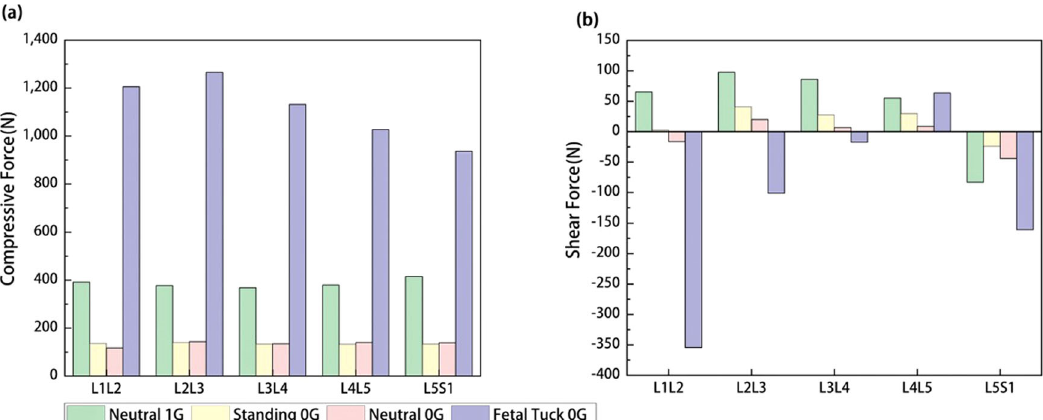
Fig. 2 Comparison of mechanical forces on lumbar discs among various postures in 1G gravity and microgravity. a Compressive force and b shear force among Neutral 1G, Standing 0G, Neutral 0G, and Fetal Tuck 0G.